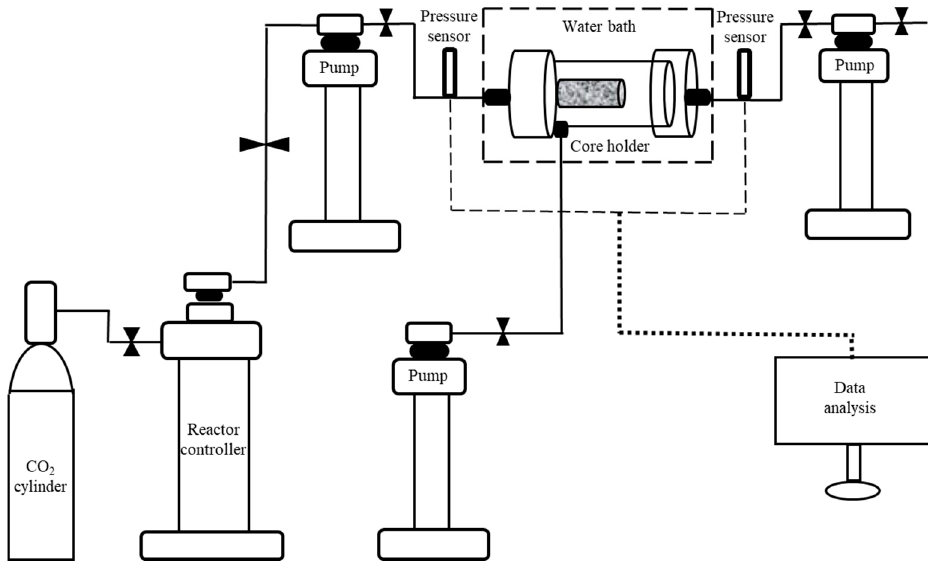
Figure 1. Schematic of the core flooding system (modified from [50]).